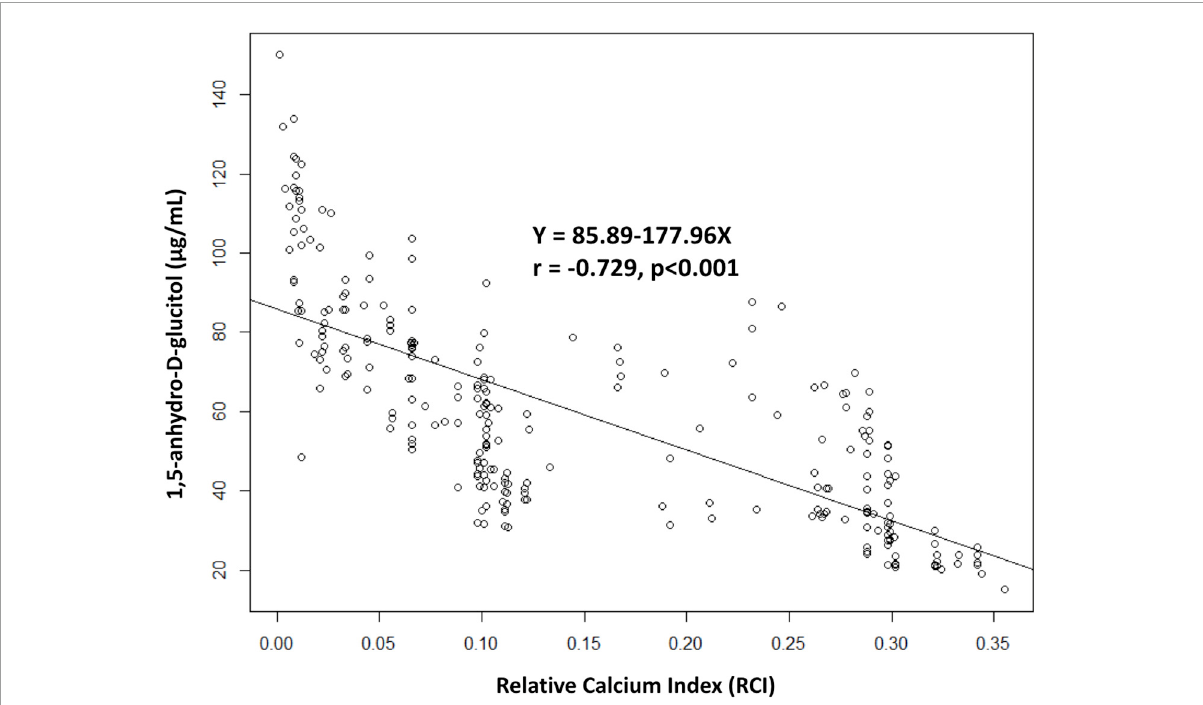
FIGURE3 Correlations between serum 1,5-AG level and relative calcium index. 1,5-AG, 1,5-anhydro-D-glucitol.